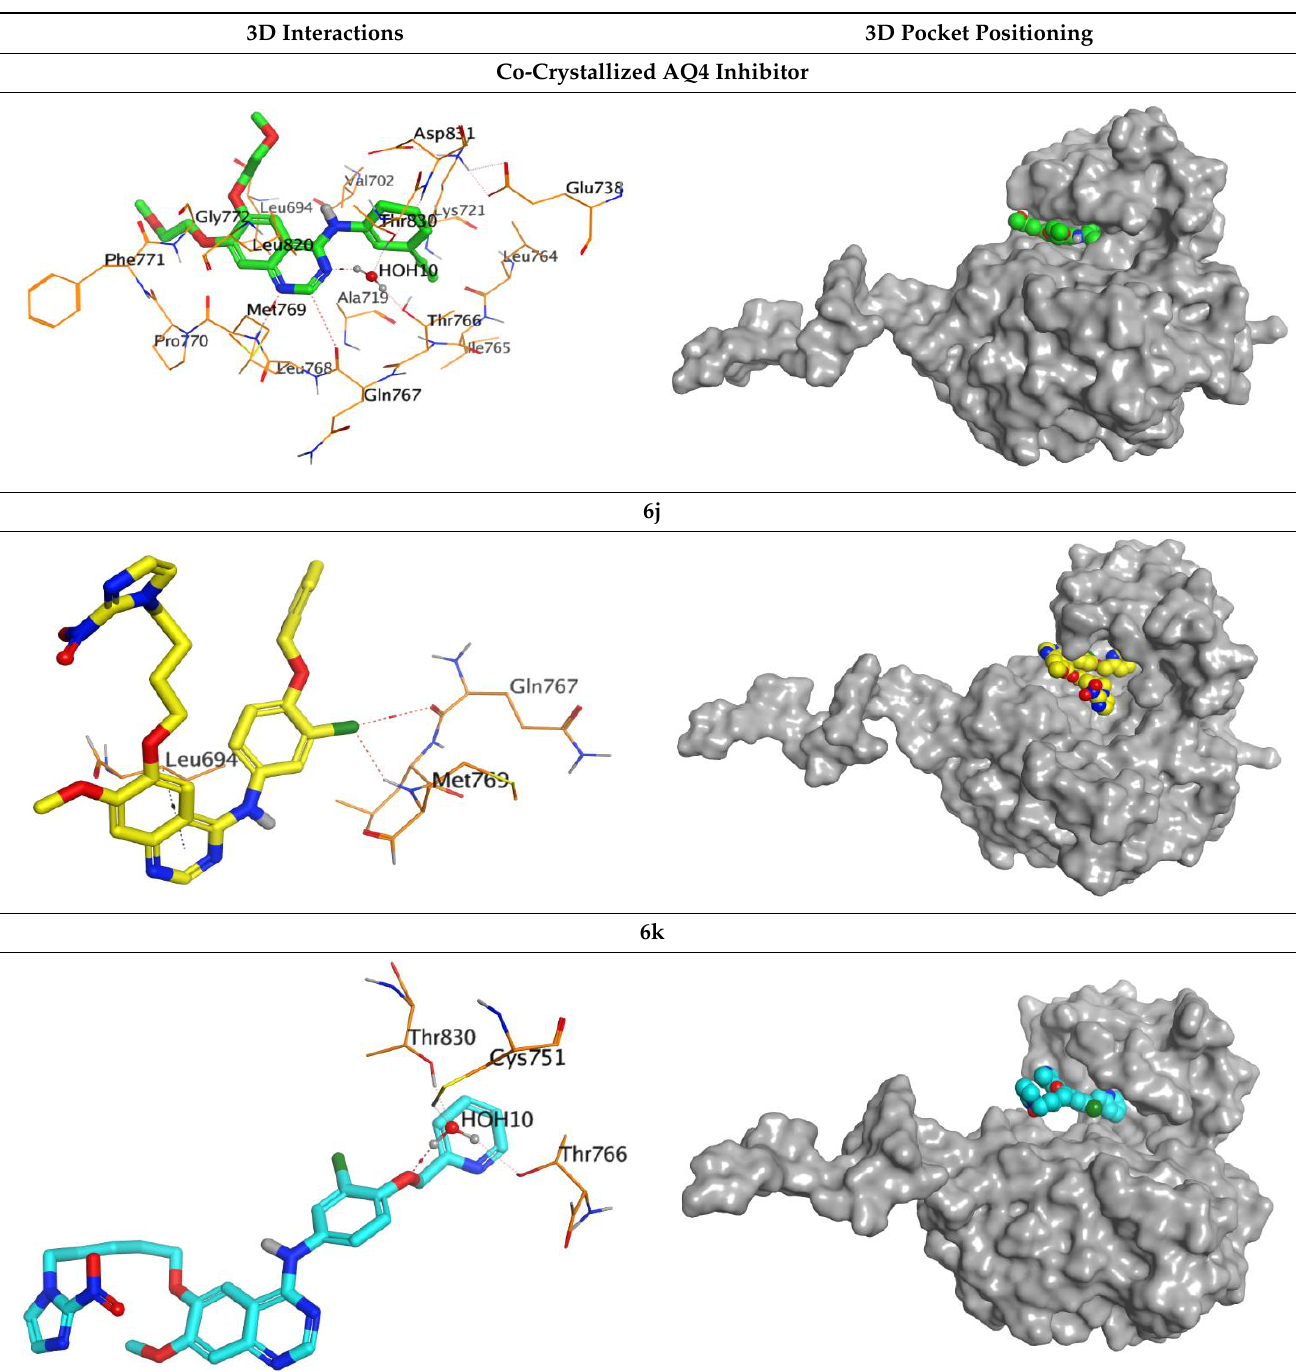
Table 6. 3D binding interactions and positioning of the co-crystallized AQ4 inhibitor, 6j , and 6k candidates within the EGFR (PDB ID: 1M17) binding pocket.